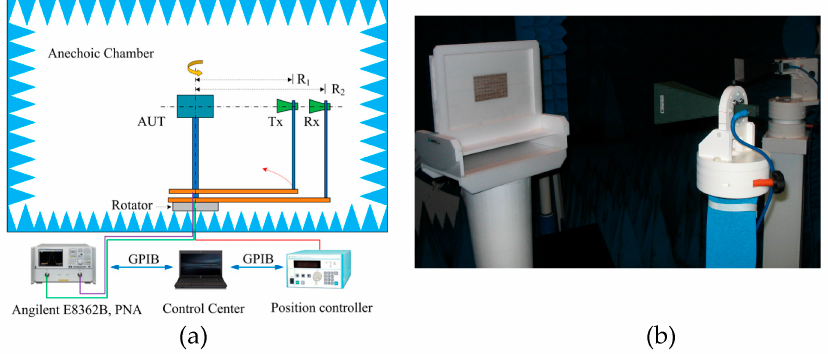
Figure 6. ( a ) Schematic of the reflectarray measurement system. ( b ) Photos of transmitting/receiving antennas and reflectarray under test.